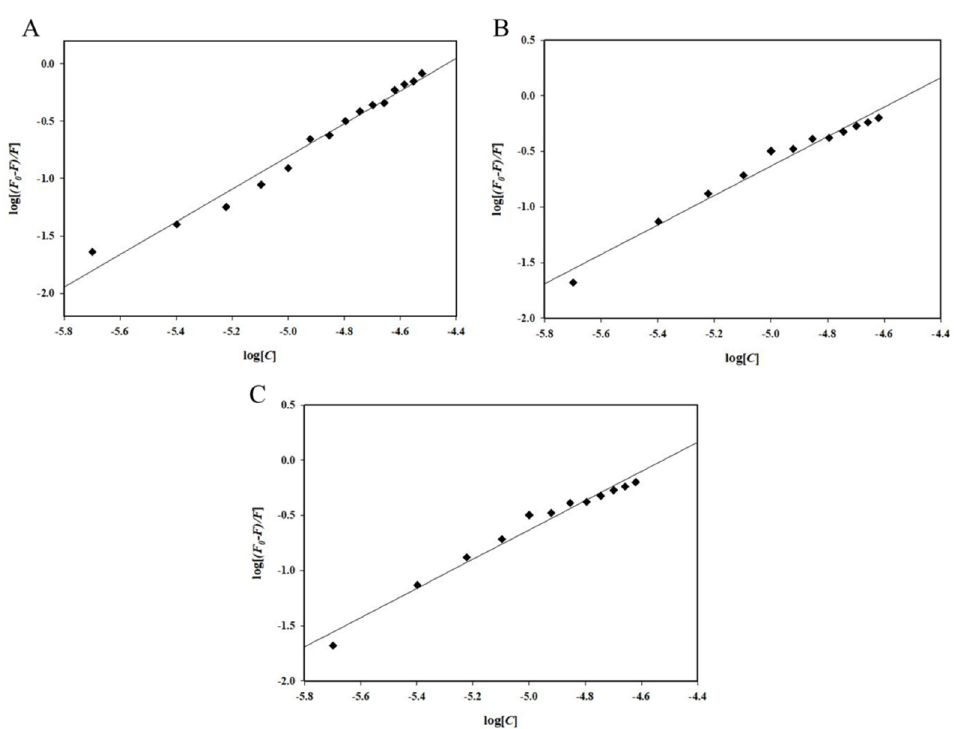
Figure 4. Double logarithmic plot for the quenching of irisin fluorescence by ( A ) Fluoxetine, ( B ) Memantine, and ( C ) Galantamine. Table 1. Values of Stern–Volmer quenching constants obtained from Stern–Volmer equation. Table 2. Binding parameters obtained from double logarithmic